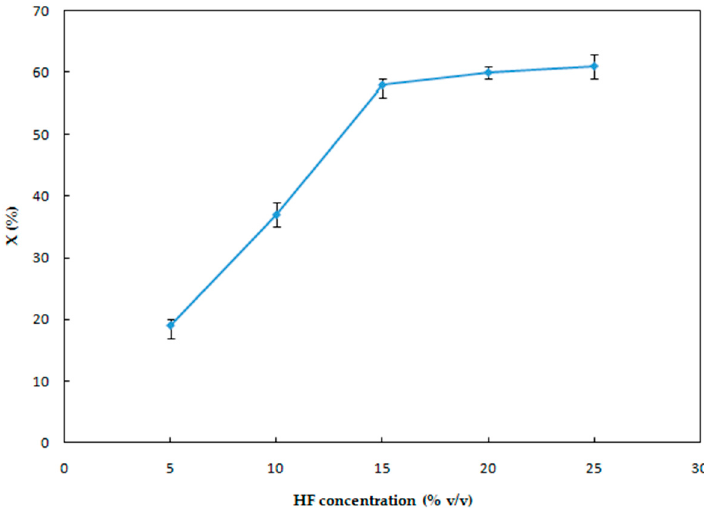
Figure 3. Effect of HF concentration on the dissolution of LiCoO 2 .